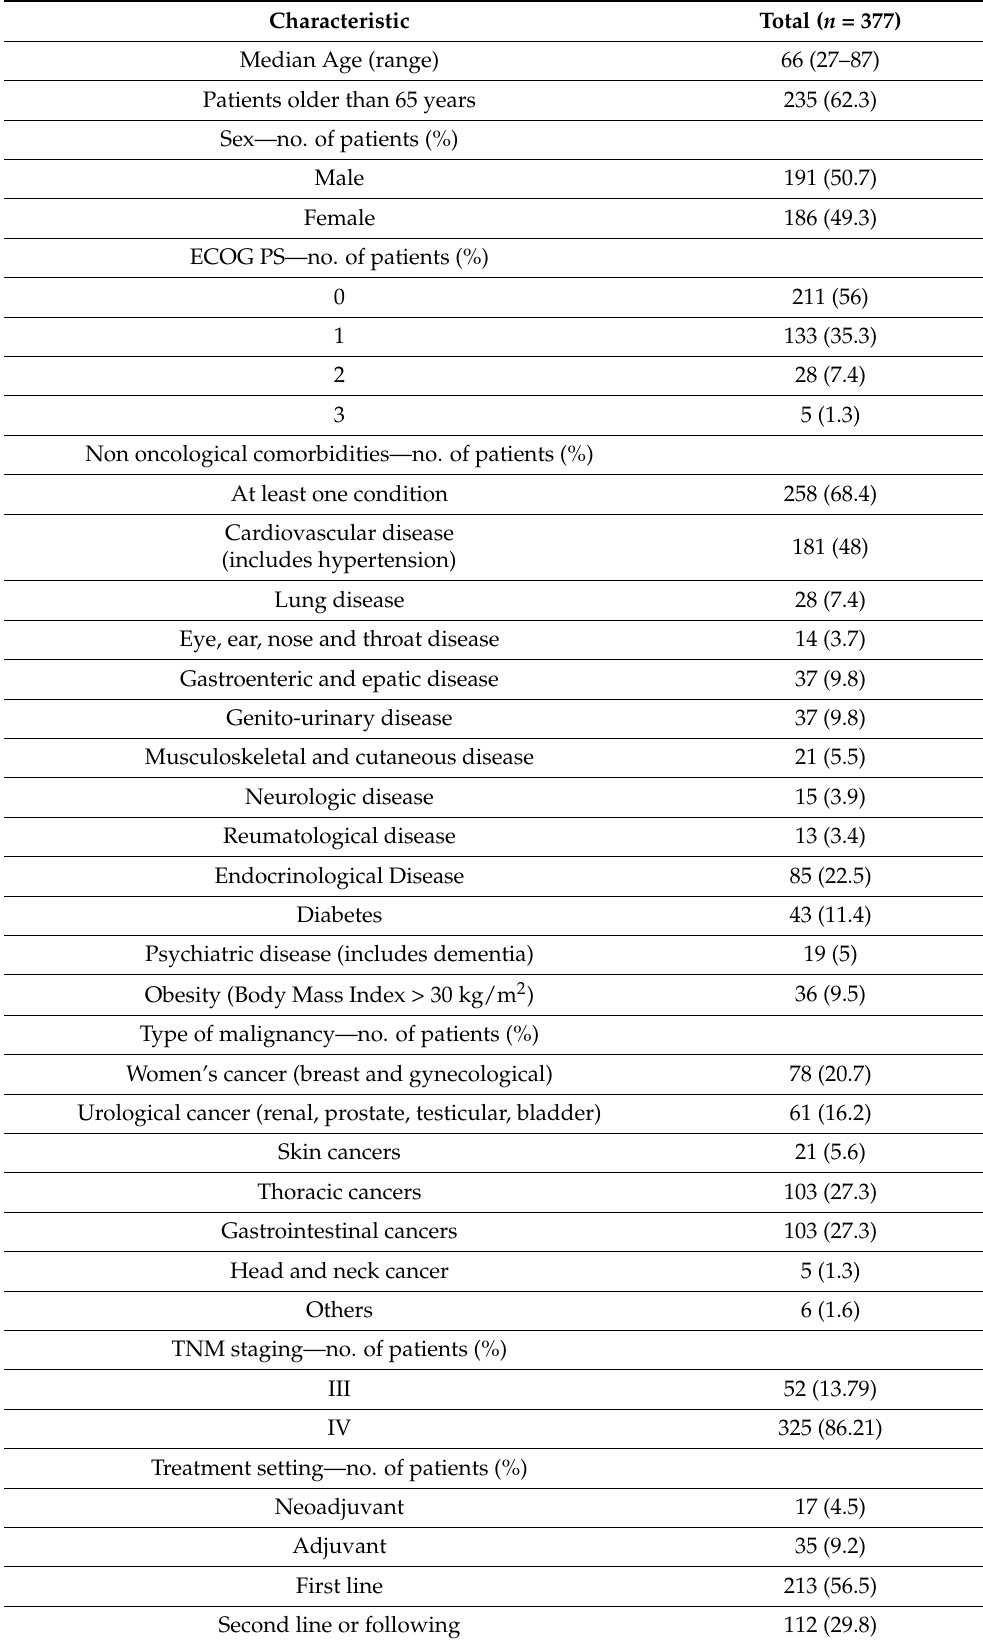
Table 1. Patients’ demographic and clinical